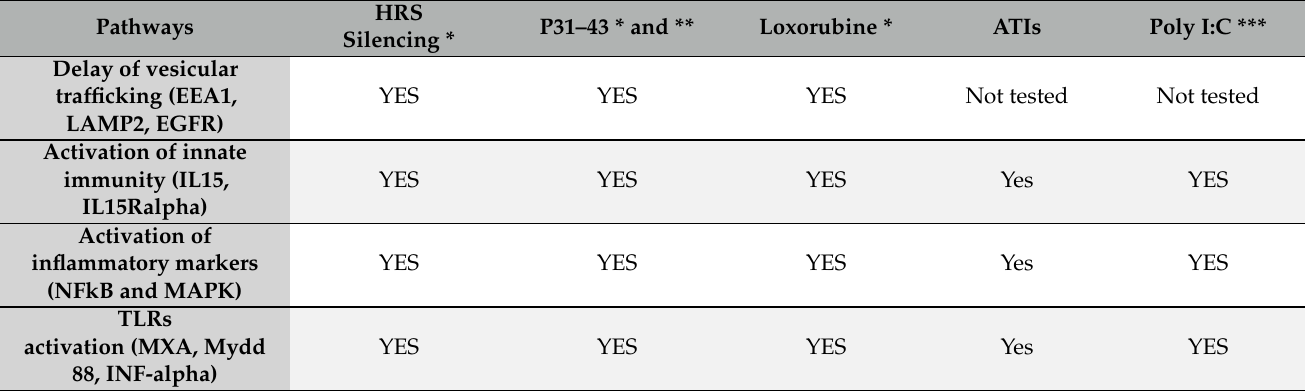
Table 1. Similarity of P31–43, viral ligands, and delay of the endocytic trafficking effects on Caco2 * cells, intestinal biopsies from CD patients ** and mice ***, on different pathways as indicated. Pathways